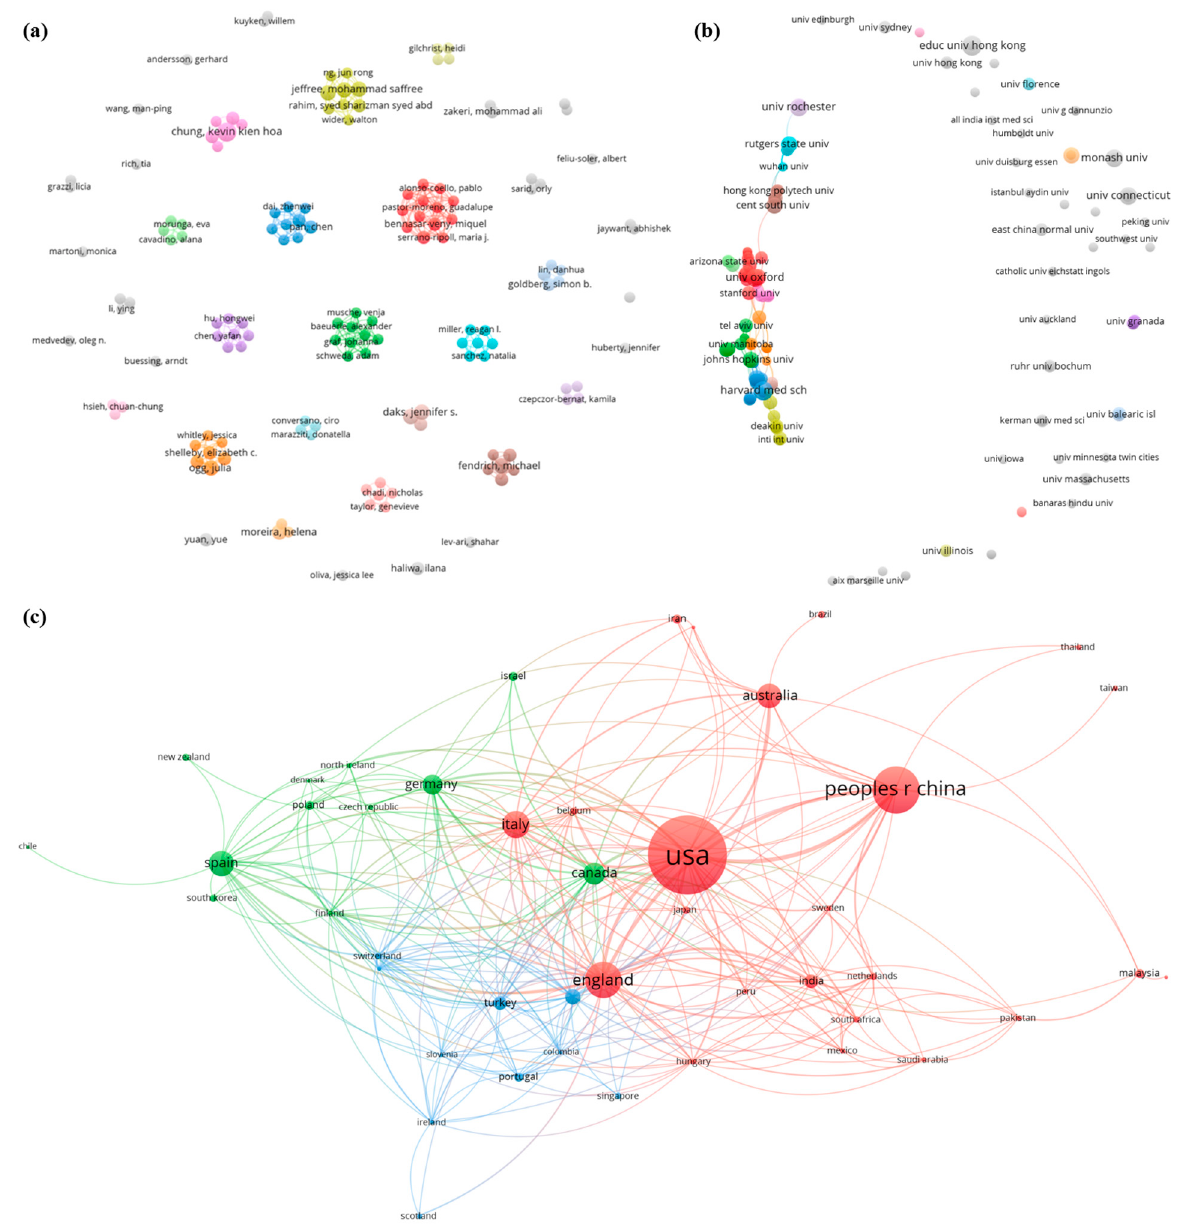
Figure 4. The cooperation pattern of ( a ) authors, ( b ) organizations, and ( c ) countries on mindfulness research topics in the COVID-19 era.